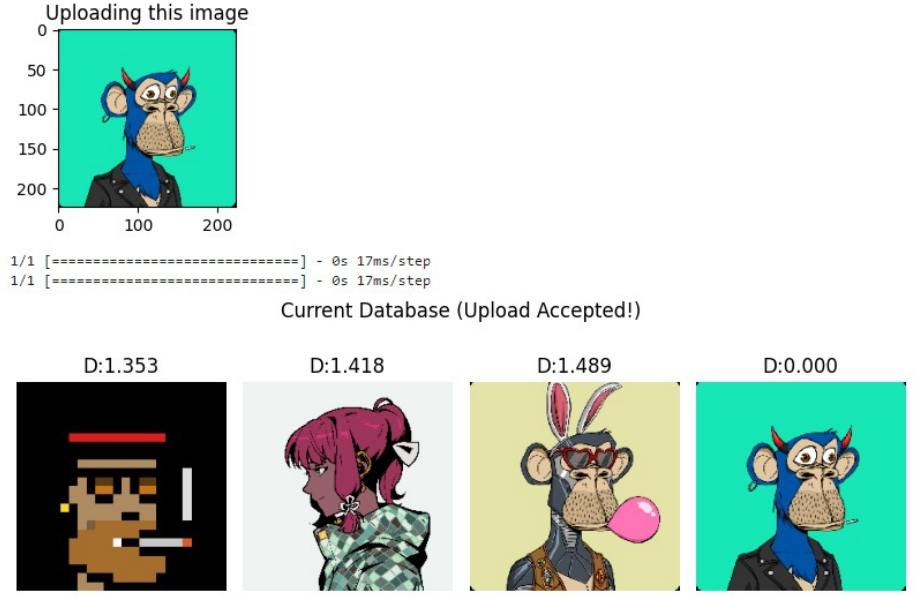
Figure 16. Simulation of uploading original NFT